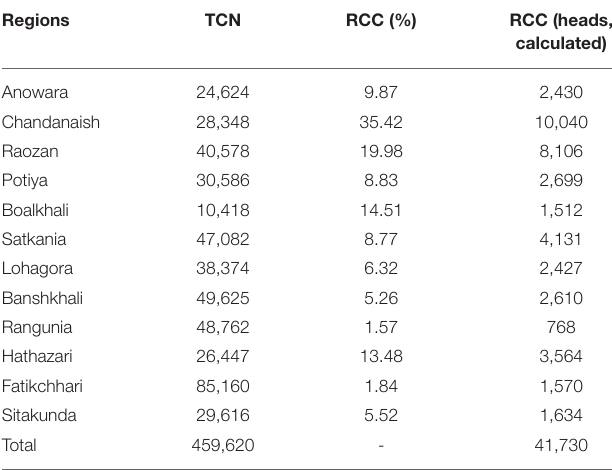
TABLE 1 | Number of Red Chittagong cattle at Chittagong, Bangladesh (2008). Regions TCN RCC